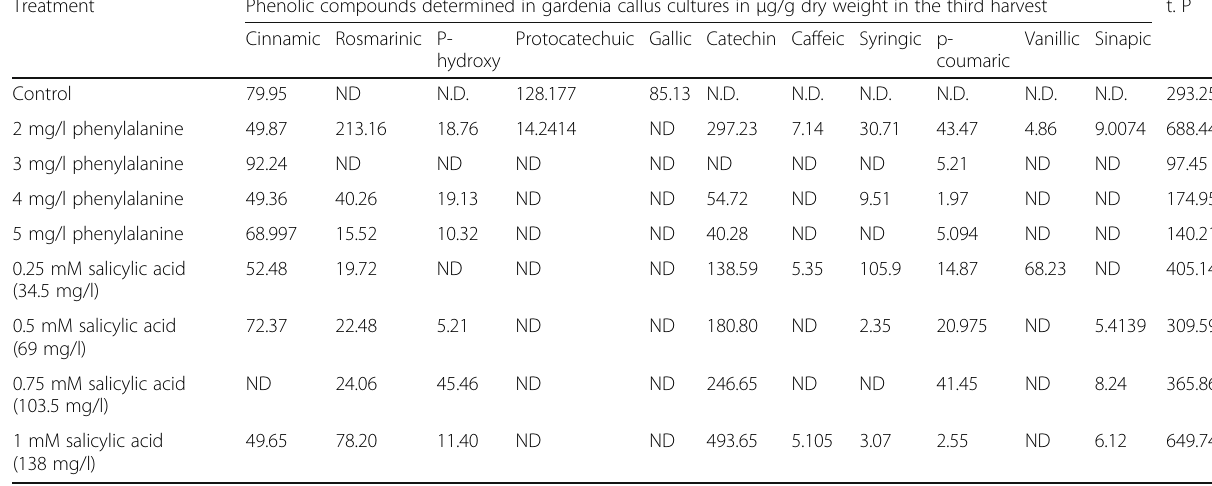
Table 7 Phenolic compound determination in gardenia calli cultures cultured on MS media contained different concentrations of phenyl alanine or salicylic acid during the third harvested period of culturing by HPLC Treatment Phenolic compounds determined in gardenia callus cultures in μ g/g dry weight in the third harvest t. P